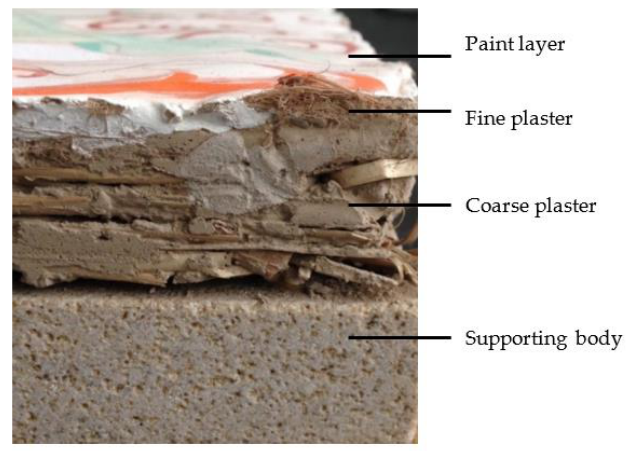
Figure 3. The profile of the sample.